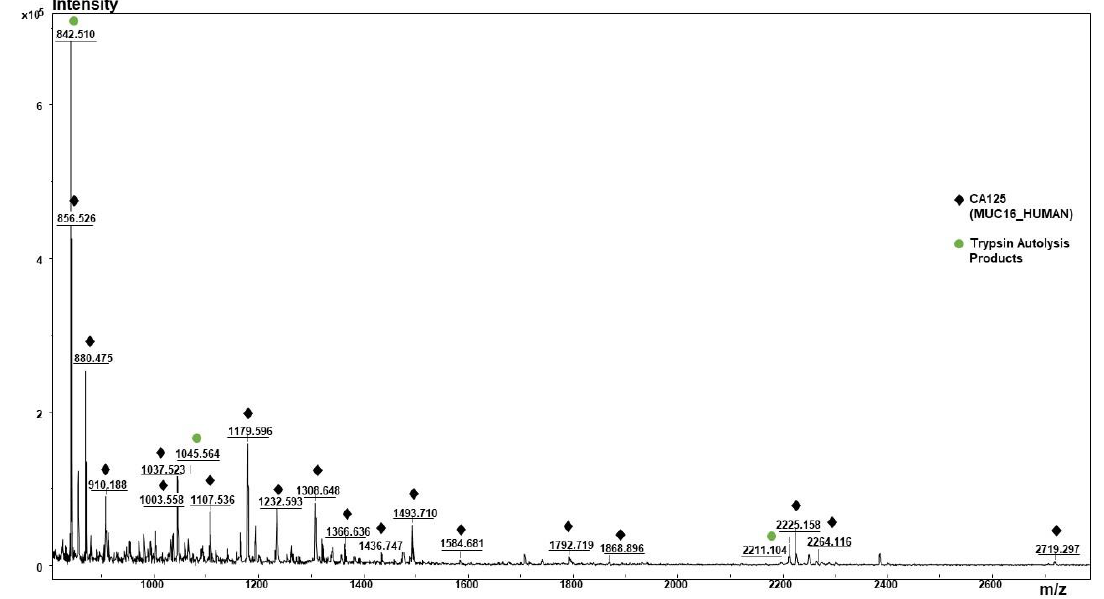
Figure 4. MALDI mass spectra of objects captured onto the surface of SOI substrate No. 1 after its incubation in 10-nM solution of CA 125. Markers indicate CA 125-related peptides (rhombs) and trypsin autolysis peaks (circles).